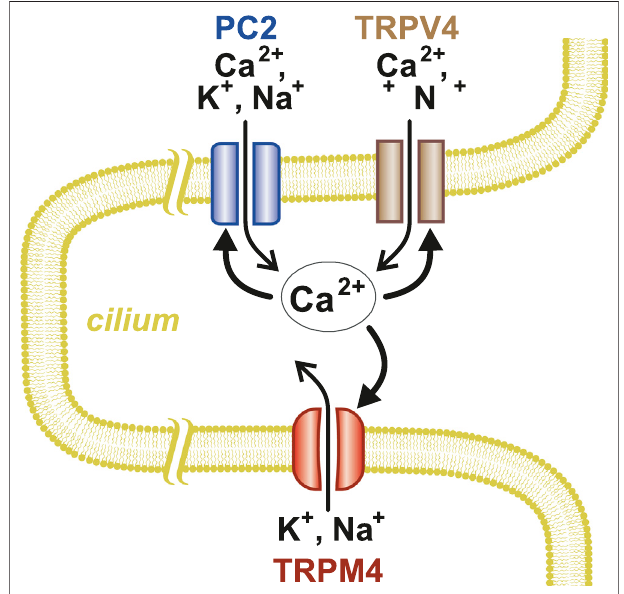
FIGURE 10 | Model of Ca 2+ signaling and ampli fi cation in renal primary cilium. PC2 and TRPV4, but not TRPM4, can conduct Ca 2+ into the cilium. An increase in intraciliary Ca 2+ can further activate all three of the channel